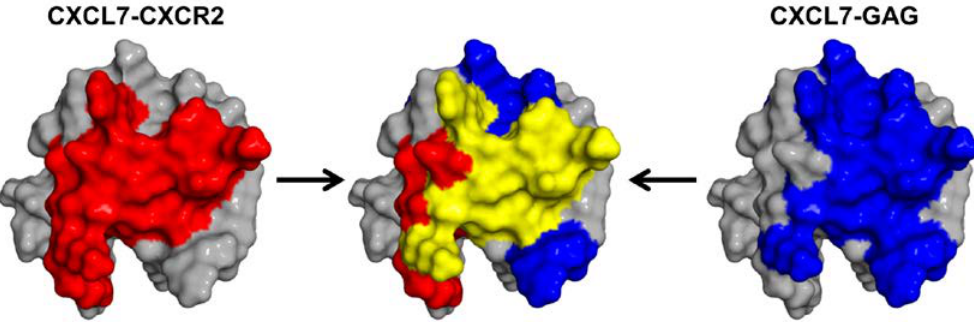
Figure 8. Overlap between GAG and CXCR2 binding domains. A schematic showing the CXCR2 binding domain (red), GAG binding domain (blue) and the overlap between the two domains (yellow).